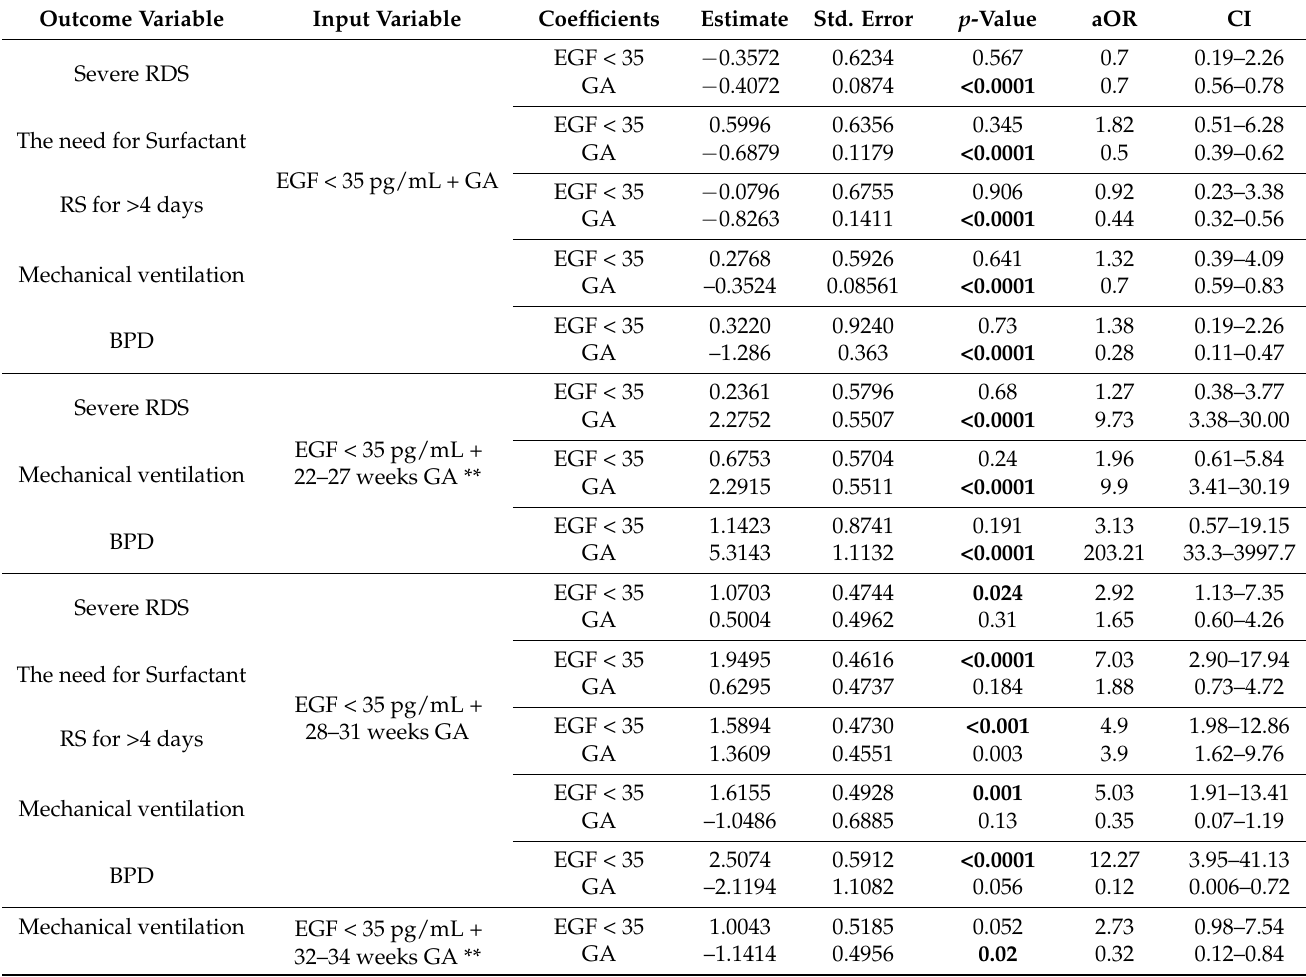
Table 2. The multiple regression analysis for respiratory outcomes with EGF cut–off level < 35